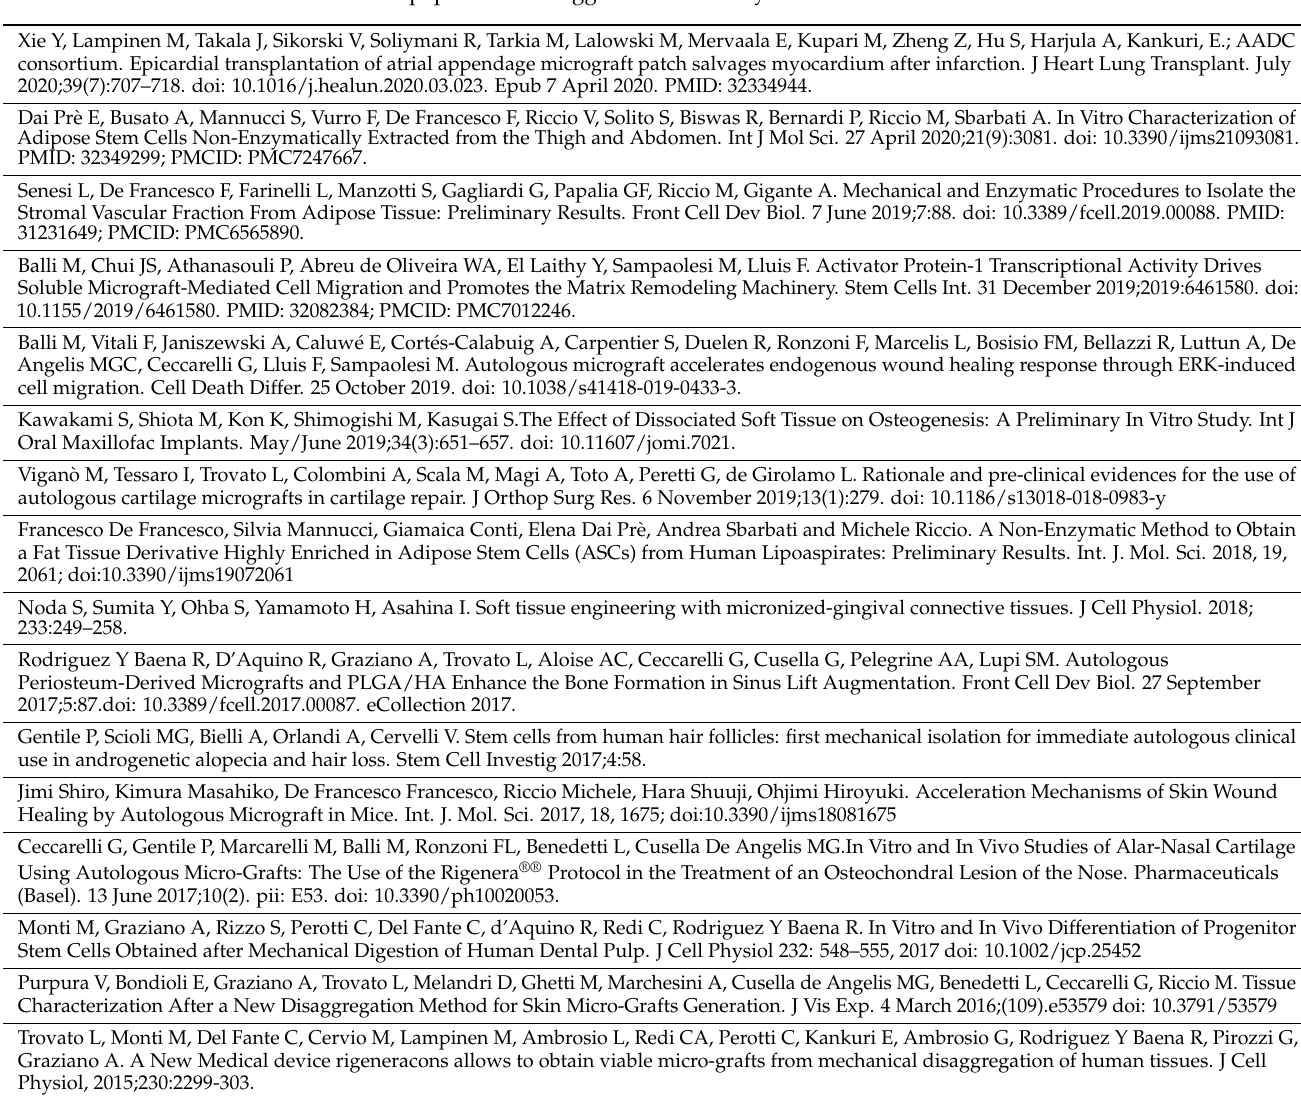
Table 1. List of the papers which suggest the suitability of the device for in vitro